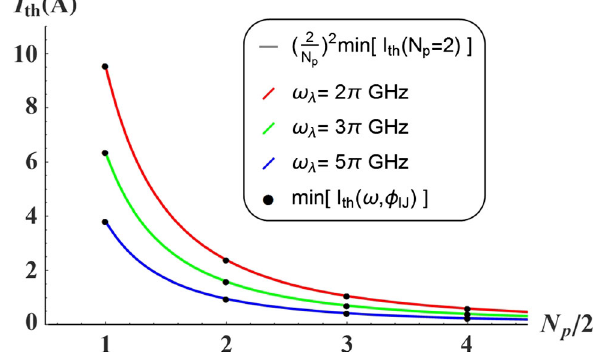
(cid:3) over N p for symmetric ERLs th ¼ 0 . 5 m, t ¼ t , Q λ ¼ 100 , b rf rf − t ¼ 100 t t (with an additional 1 I þ 1 I 2 rf rf